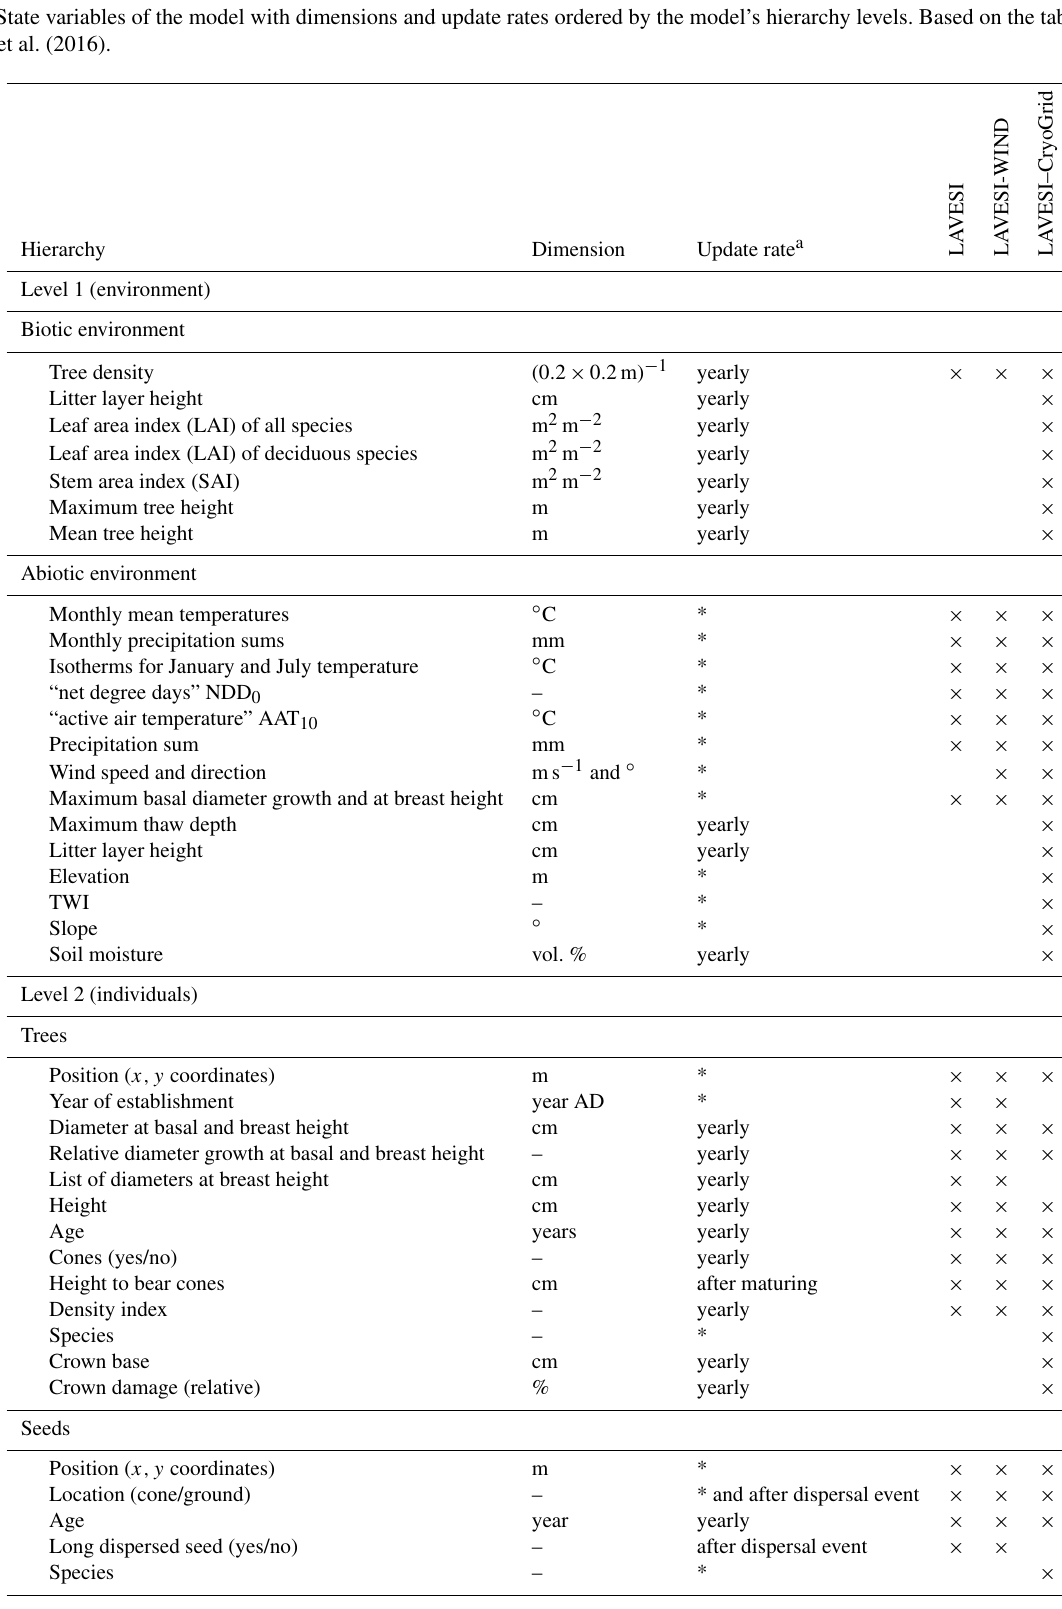
Table 1. State variables of the model with dimensions and update rates ordered by the model’s hierarchy levels. Based on the table provided in Kruse et al.